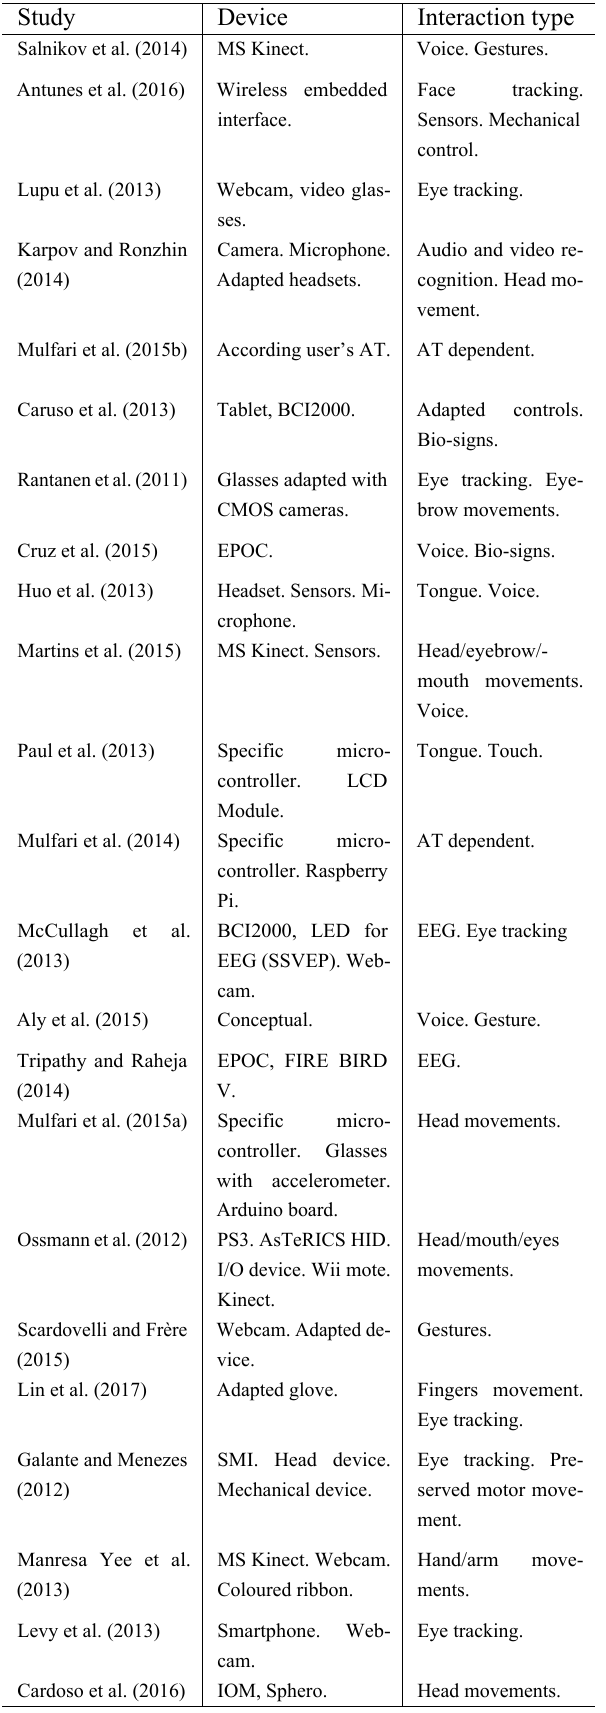
Tabela 2. Prototypes’